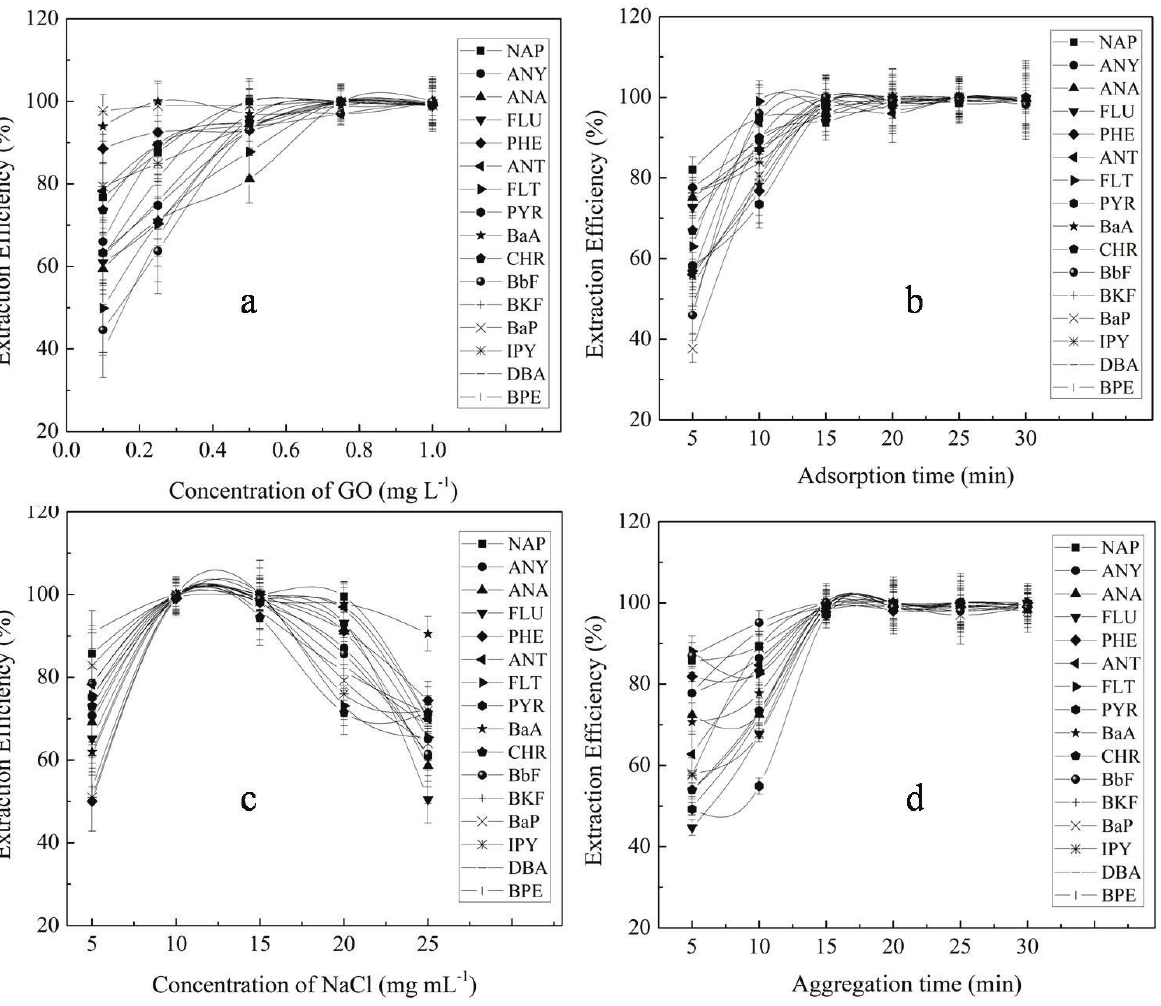
Figure 4: Optimization of the effects of influencing parameters on the extraction efficiency of PAHs. (a) Effect of concentration of GO. Adsorption time, 15 min; concentration of NaCl, 10 mg mL -1 ; and aggregation time, 15 min. (b) Effect of concentration of Adsorption time. Concentration of GO, 1.0 mg L -1 ; concentration of NaCl, 10 mg mL -1 ; and aggregation time, 15 min. (c) Effect of concentration of NaCl. Concentration of GO, 1.0 mg L -1 ; adsorption time, 15 min; and aggregation time, 15 min. (a) Effect of aggregation time. Concentration of GO, 1.0 mg L -1 ; adsorption time, 15 min; and concentration of NaCl, 10 mg mL -1